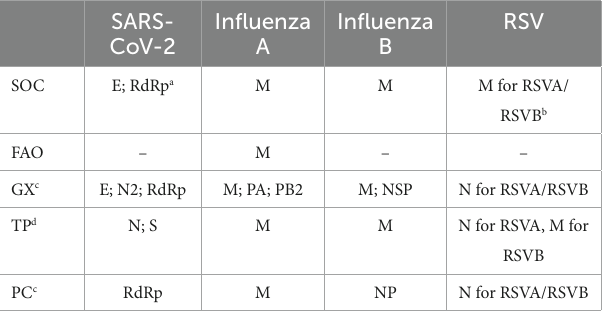
TABLE 1 Genes targeted for each virus and each